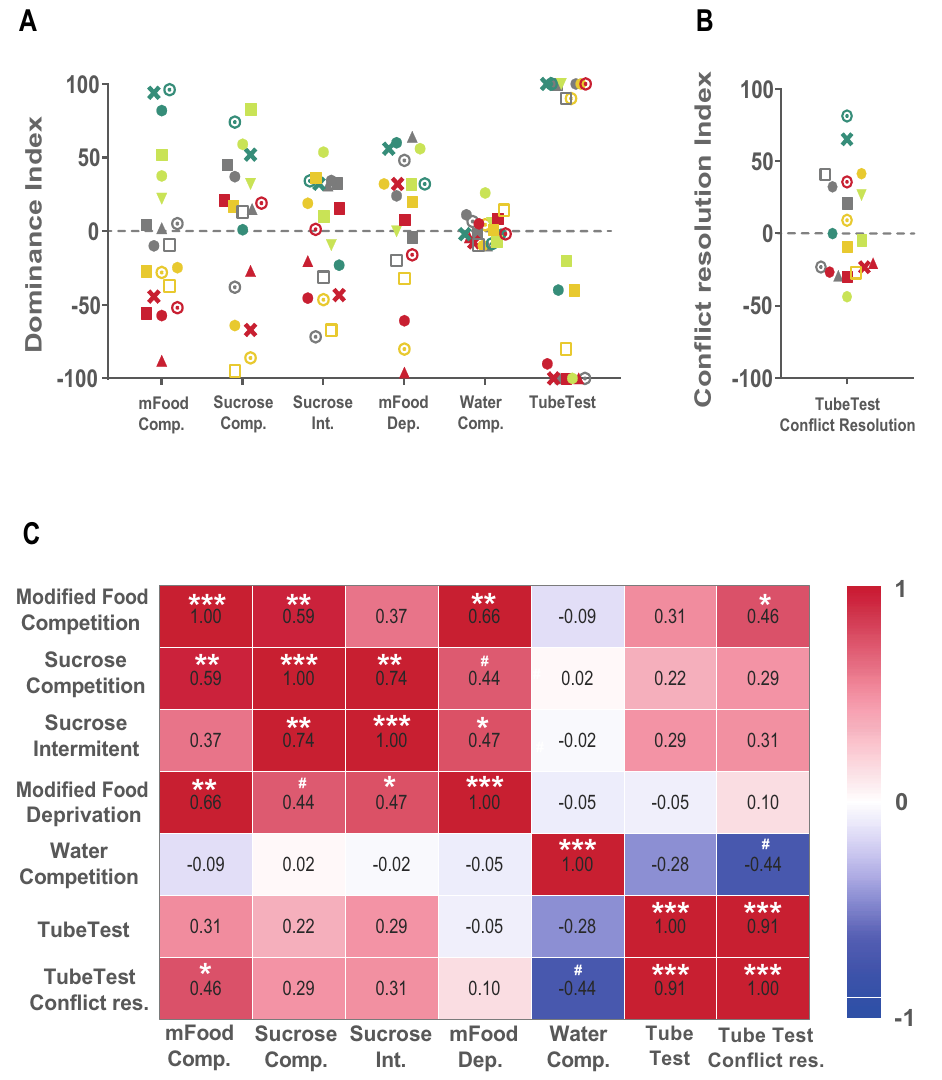
Figure 6. Reliability between dominance measurements between tests. ( A ) Dominance index (DI) based in consumption of resources for each behavioral test is represented being each pair of animals identified with a specific color/symbol. In those cases where two days of testing was performed, values plotted correspond to the average DI of the two days. Competition for positive reinforcers produced highly variable DI indicating detectable differences in the strength of social hierarchy between the pairs. Water Competition, however produced DI close to 0 indicating that the animals of most of the dyads drank very similar amounts during this test. The Tube Test produced a very polarized distribution of DI, where one animal of each pair would win most of the trials. ( B ) These differences in hierarchy became less polarized when taking into account the time the animals took to solve the conflict in the tube (DI in the Tube Test /latency to finish the trial). ( C ) Correlation matrix between DI from all tests. Competition for positive reinforcers DIs were correlated across tests, and DI from the modified Food Competition test correlated with the Tube Test, when conflict resolution time was taken into account. However, no significant correlations were observed with the Water Competition tests. # p < 0.10, * p < 0.05, ** p < 0.01, *** p <